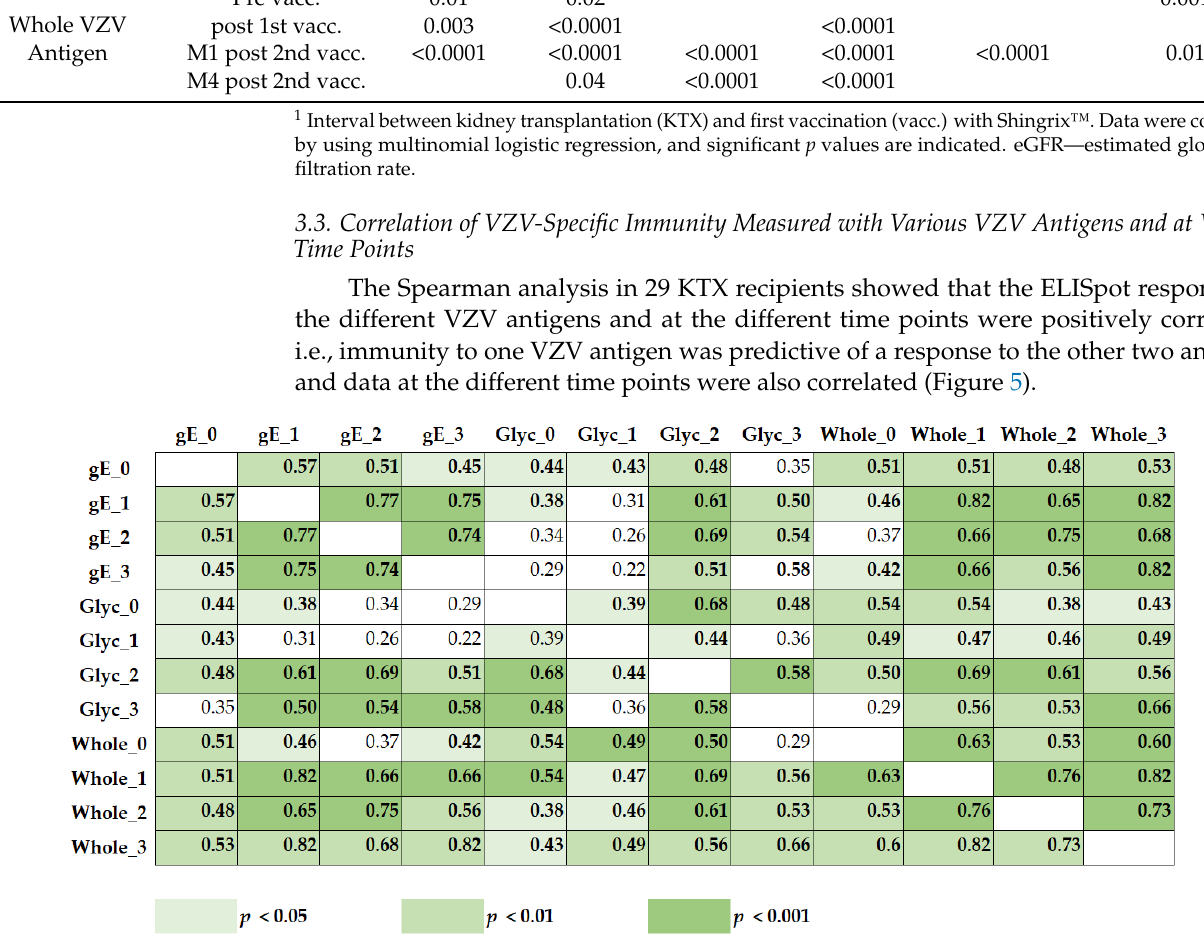
Figure 5. Spearman correlation of ELISpot responses towards a peptide pool of glycoprotein E (gE), a native glycoprotein (Glyc), and a whole varicella–zoster virus (Whole) in 29 kidney transplant recipients. Each patient was tested four times, i.e., prior to vaccination (0), after the first vaccination (1), at month 1 after the second vaccination (2), and at month 4 after the second vaccination (3). The numbers indicate the correlation coefficient r , which always showed a positive correlation (0.22 – 0.82). Significant correlations are highlighted in bold; the color indicates the level of significance.